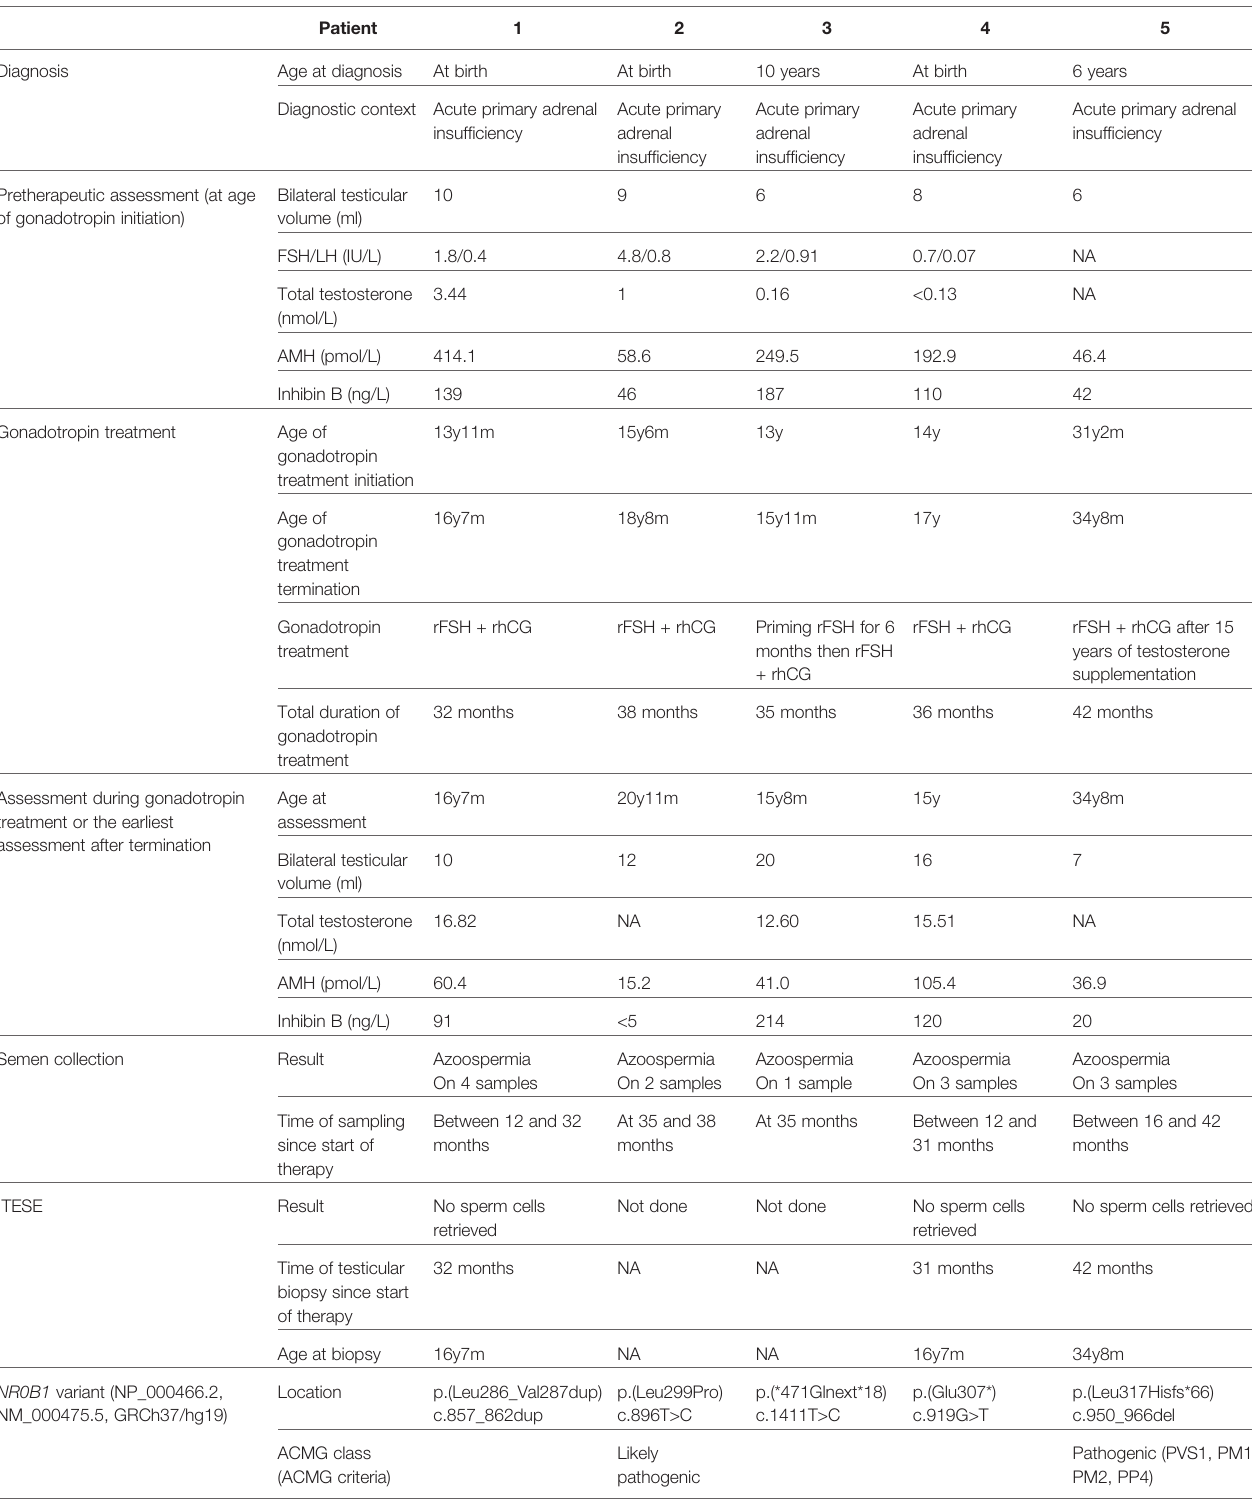
TABLE 1 | Patients ’